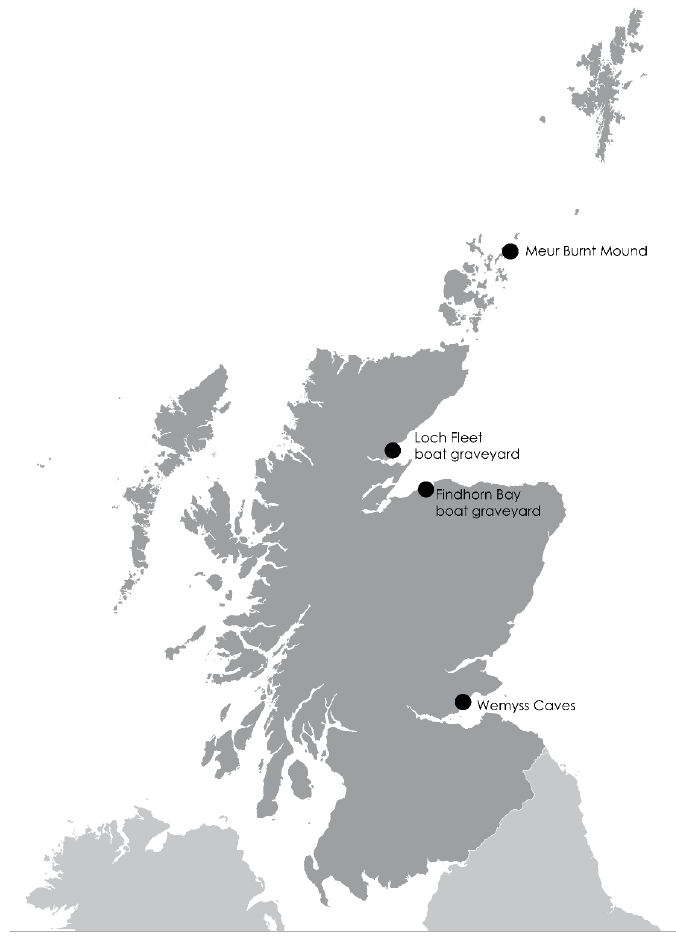
Figure 2. Map showing locations of ShoreDIG case studies.